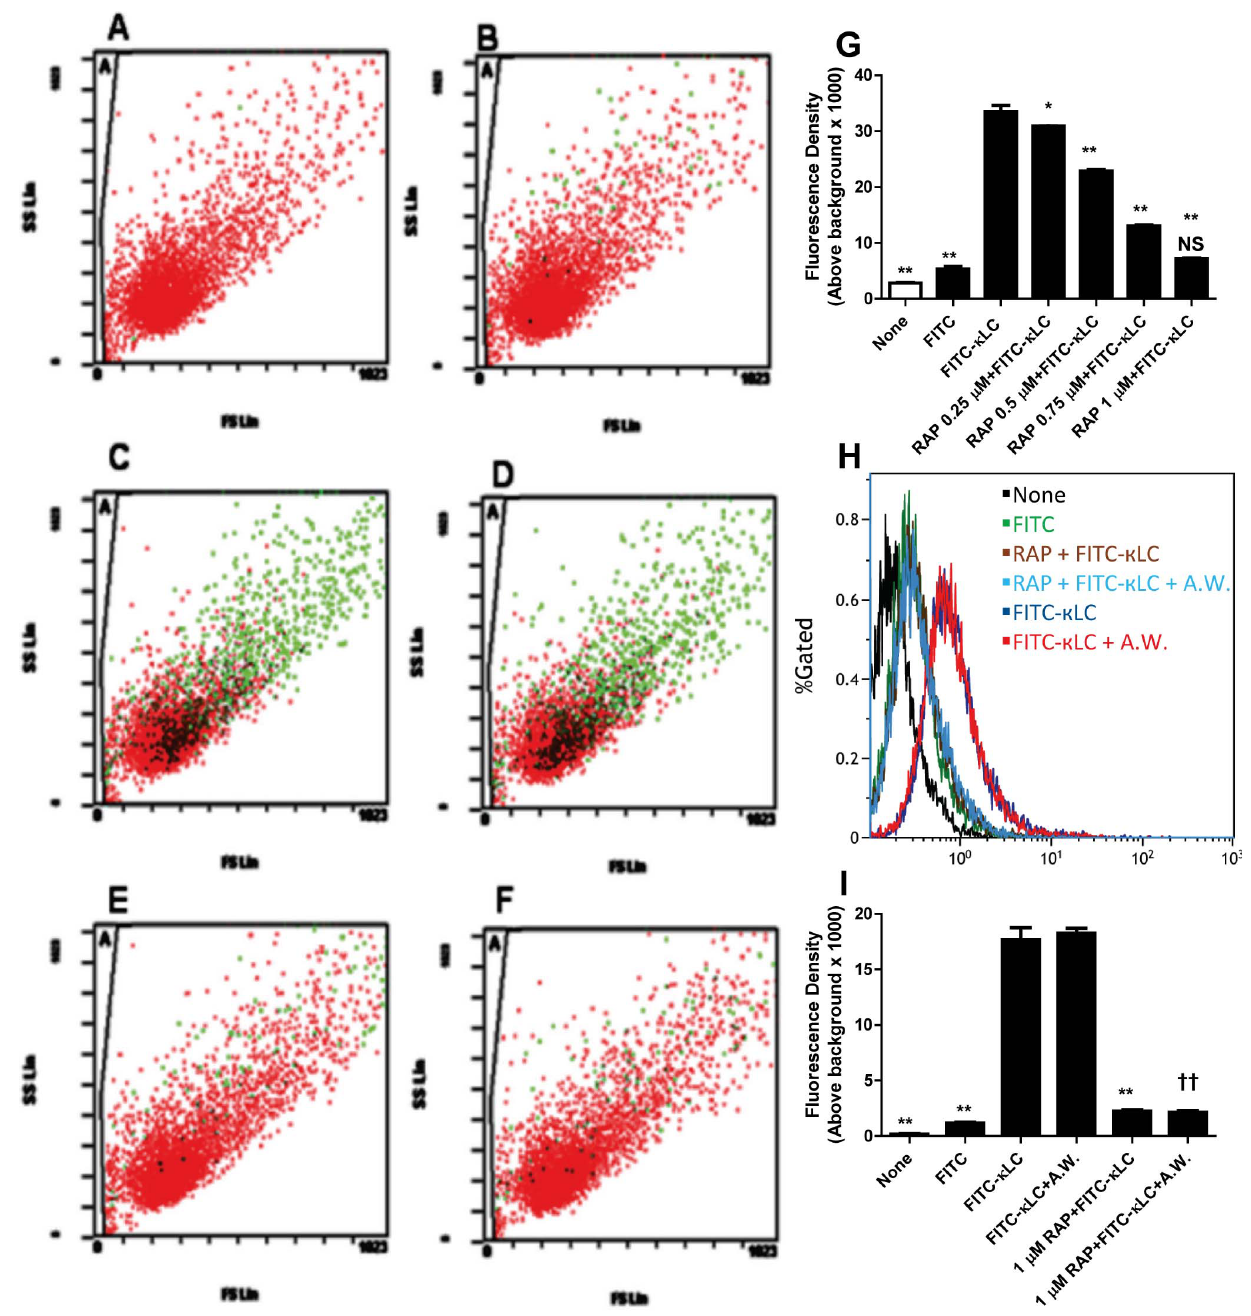
Figure 2. Flow cytometry (A – F) showing the effect of RAP treatment on the association of fluorescently labeled human myeloma light chain (LC) by human renal proximal tubule cells. Cells with FITC association are represented in green color. ( A =cells without LC, B =cells with FITC alone, C =cells with 25 m M FITC- k LC, D =cells with 25 m M FITC- k LC + acid wash, E =cells after 1 m M RAP and with 25 m M FITC- k LC, F =cells after 1 m M RAP + 25 m M FITC- k LC + acid wash). Quantitative presentation of flow cytometric events showing the inhibitory effect of RAP on the association of 25 m M FITC- k LC in HK2 cells is dose-dependent G ). *p , 0.05, ** , 0.01 compared to 25 m M FITC- k LC, N.S.=Not significant compared to FITC alone. Histograms ( H ) represent the distributions of events for FITC-LC associated cells. Acid-wash had no discernible effect on the magnitude of FITC-LC association with the cells, suggesting that membrane association is negligible. The percent magnitude of fluorescence above background is shown in the bar graph ( I ): Control non-FITC conjugated LC=0.18 6 0.03%; FITC alone=1.16 6 0.10; 25 uM FITC- conjugated k -LC=17.59 6 1.06%; 25 uM k -LC + A.W=18.25 6 0.46%; 1 uM RAP + 25 uM FITC- k -LC=2.24 6 0.11%; 1 uM RAP + 25 uM FITC- k -LC + A.W.=2.14 6 0.11%. RAP, 1 m M, reduced the association of total FITC-LC with cells by 87.3% compared to cells exposed to FITC- k -LC (down to 2.24 6 0.11 from 17.59 6 1.06%), and reduced acid non-washable fraction (the fraction endocytosed by cells) by 88.3%, (reduced from 18.25 6 0.46 to 2.14 6 0.11%; Mean 6 SE of three experiments, **p , 0.01 compared to 25 m M FITC- k -LC, {{ p , 0.01 compared to 25 m M FITC- k -LC + A.W.; A.W.=Acid Wash).